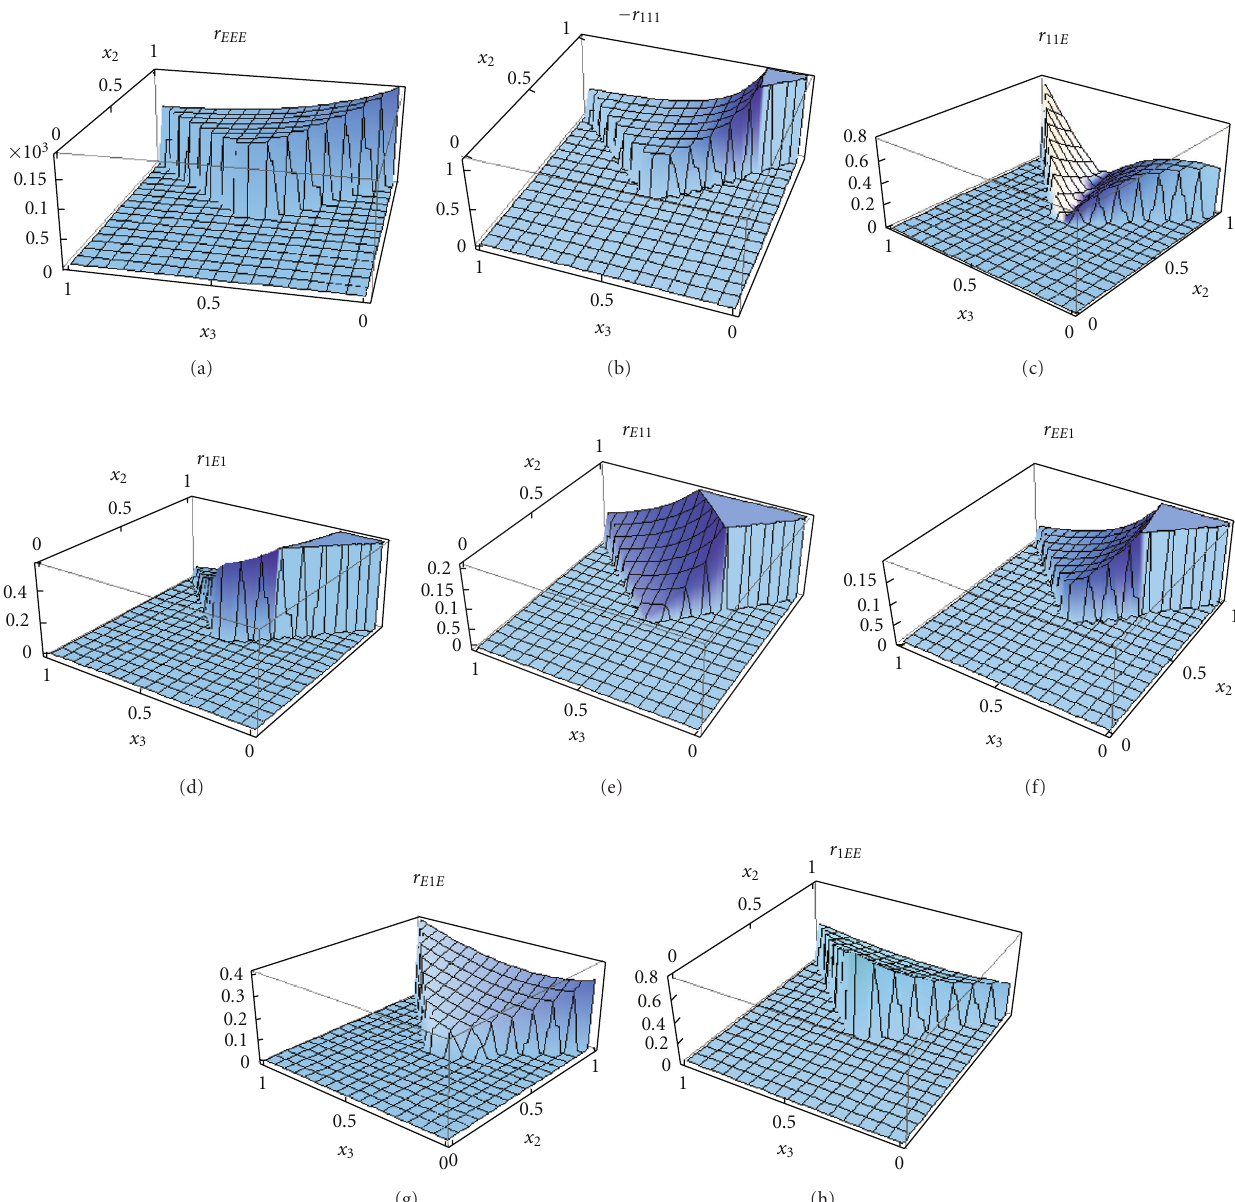
Figure 3: Plot of r n ≡ Θ ( x 2 − x 3 ) Θ ( x 3 − 1 + x 2 ) x 2 2 x 2 3 R n ( x 2 , x 3 ), where we define R n = k 6 1 F n . The Heaviside step functions Θ help restricting the plot domain to the region ( x 2 , x 3 ) that is allowed for the triangle